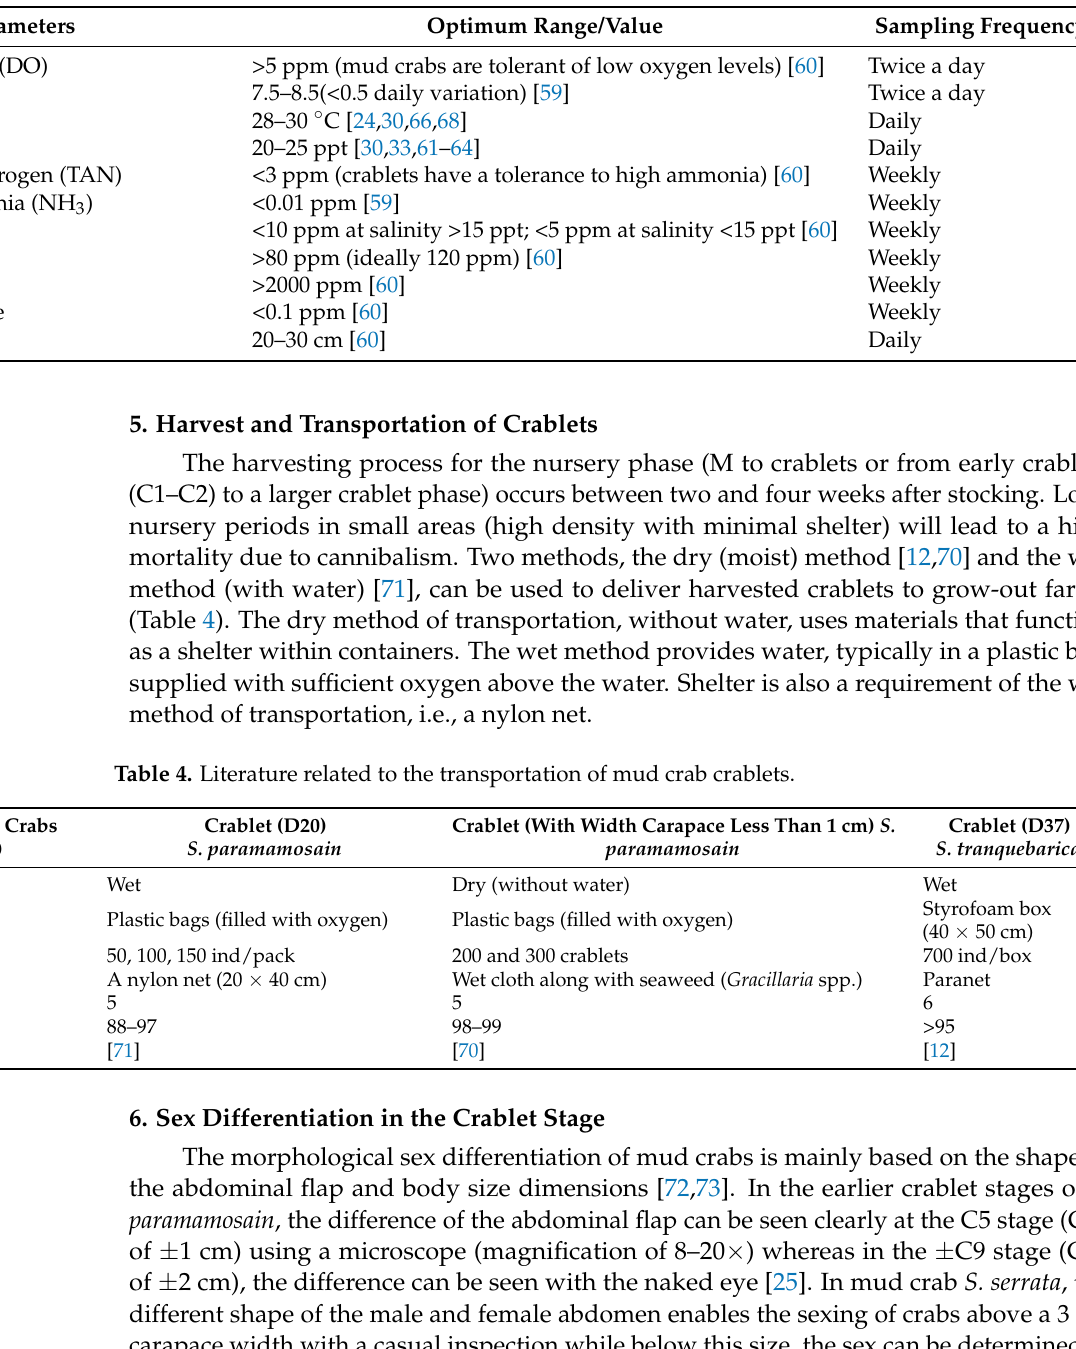
Table 3. Water quality parameters suggested for a mud crab nursery and grow-out culture operation.